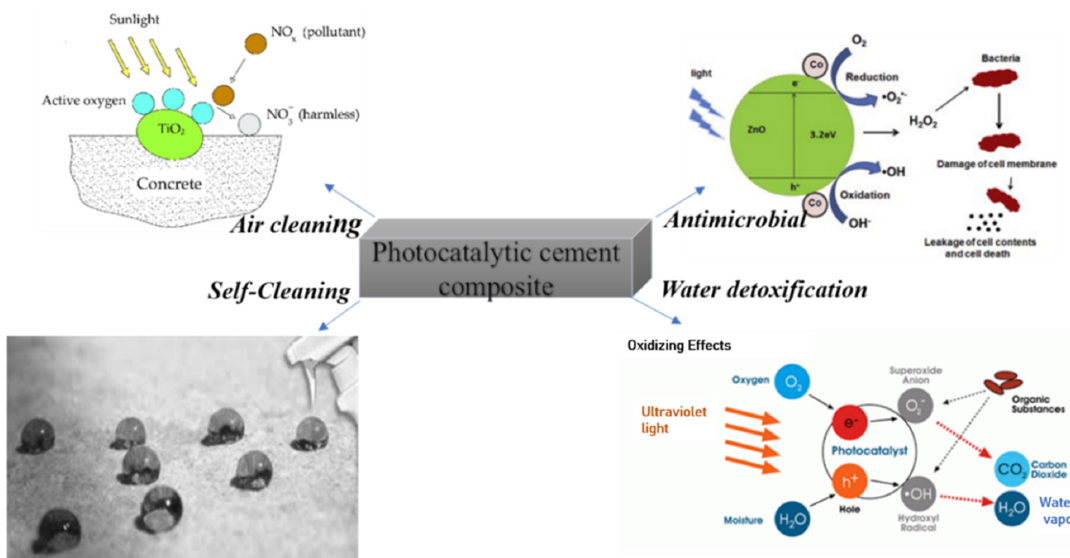
Figure 1. Various fields of application of functional construction materials.